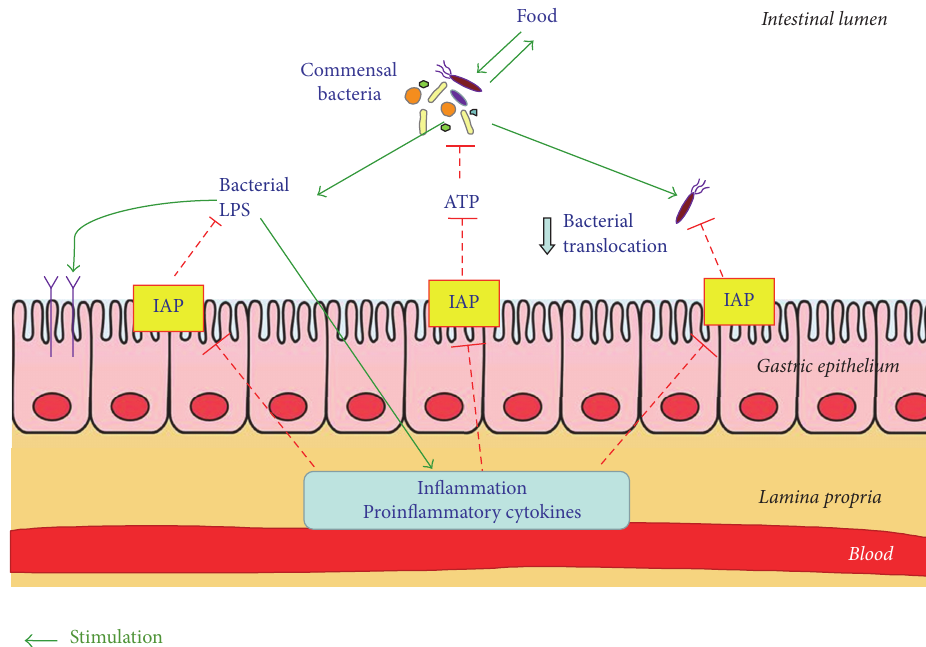
Figure 1: Hypothetical model depicting the mechanism by which a brush border enzyme intestinal alkaline phosphatase (IAP) affects the intestinal microbiota, the release of bacterial LPS-induced inflammation, and the luminal content of ATP inhibiting the commensal bacteria of different origin. Under inflammation, the proinflammatory cytokines can inhibit the content and activity of protective IAP. The IAP can dephosphorylate bacterial LPS which leads to LPS detoxification, thus preventing downstream activation of immunocytes and the subsequent inflammatory responses. The IAP can inhibit luminal ATP by the mechanism involving the ATP dephosphorylation. This enzyme was found to exert an inhibitory effect on the growth and survival of a wide spectrum of bacteria and to prevent bacteria translocation from intestinal lumen into bloodstream. The mechanisms illustrated in this figure which are described in the text were inspired by [8, 9] cited in this